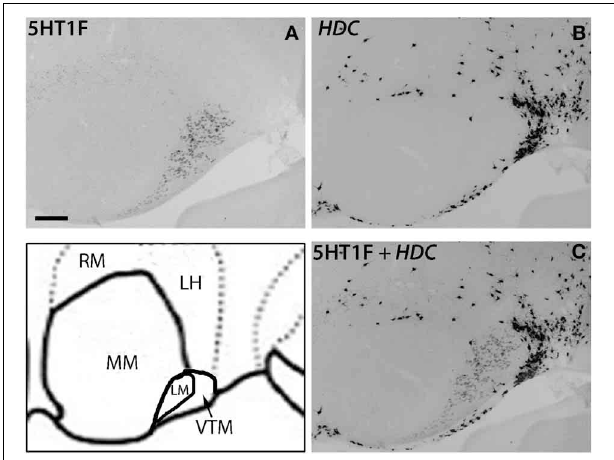
FIGURE 9 | ISH expression profiles of 5HT1F and HDC in hypothalamus. 5HT1F mRNA expression in ML (A) , HDC mRNA expression in VTM (B) , and overlay image of 5HT1F and HDC mRNA expressions (C) . Scale bar, 100 μ